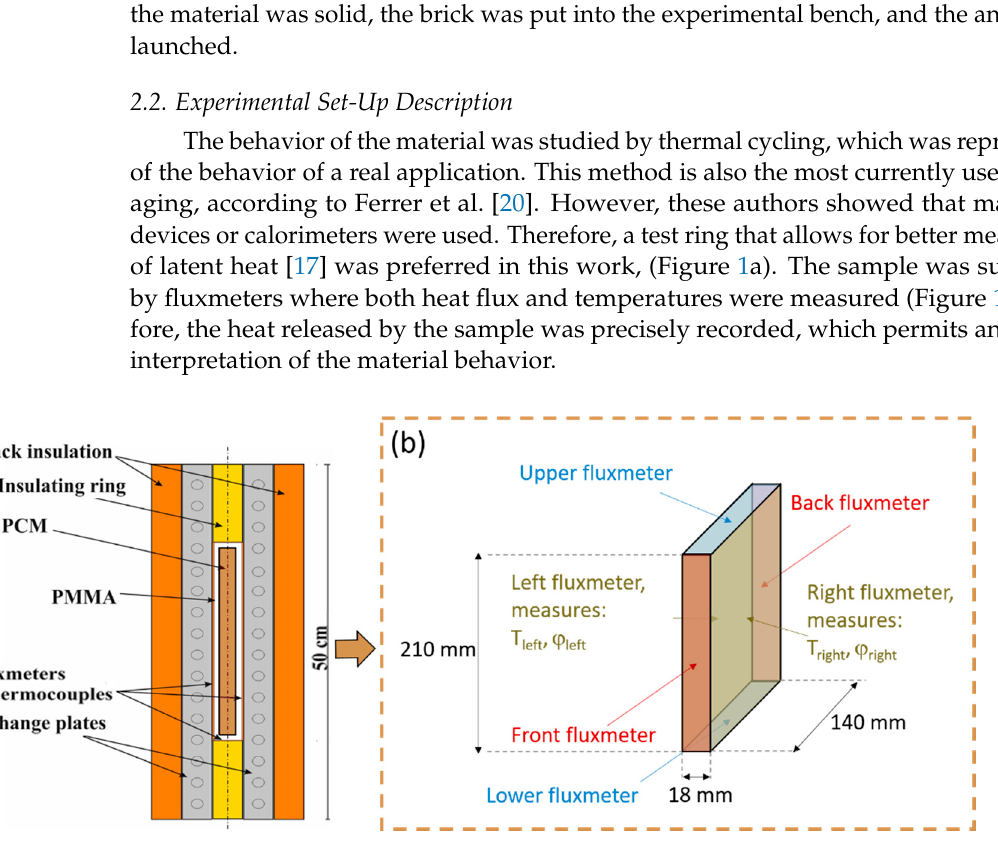
Figure 1. ( a ) Global description of the experimental bench and ( b ) focus on the sample, adapted from [21,22]. Two thermo-regulated water baths were used for temperature regulation of the ex- change plates. From preliminary experiments, it was observed that a heating and cooling rate of 20 °C.h − 1 gives repeatable conditions between left and right plates (±0.1 °C.h − 1 ) and